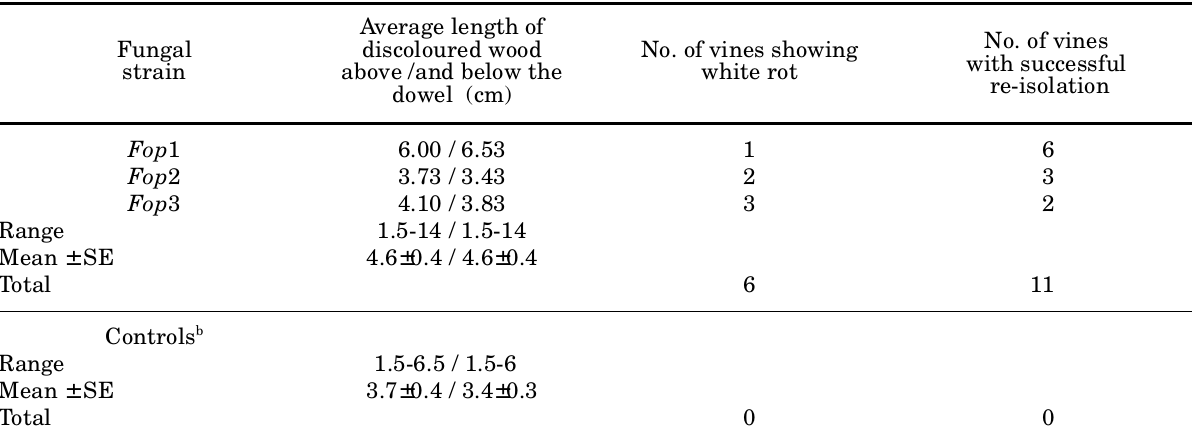
Table 2. Results of a two-year experiment with three strains of F. punctata deep-inoculated in the branches of 13- year-old grapevines cv. Sangiovese a